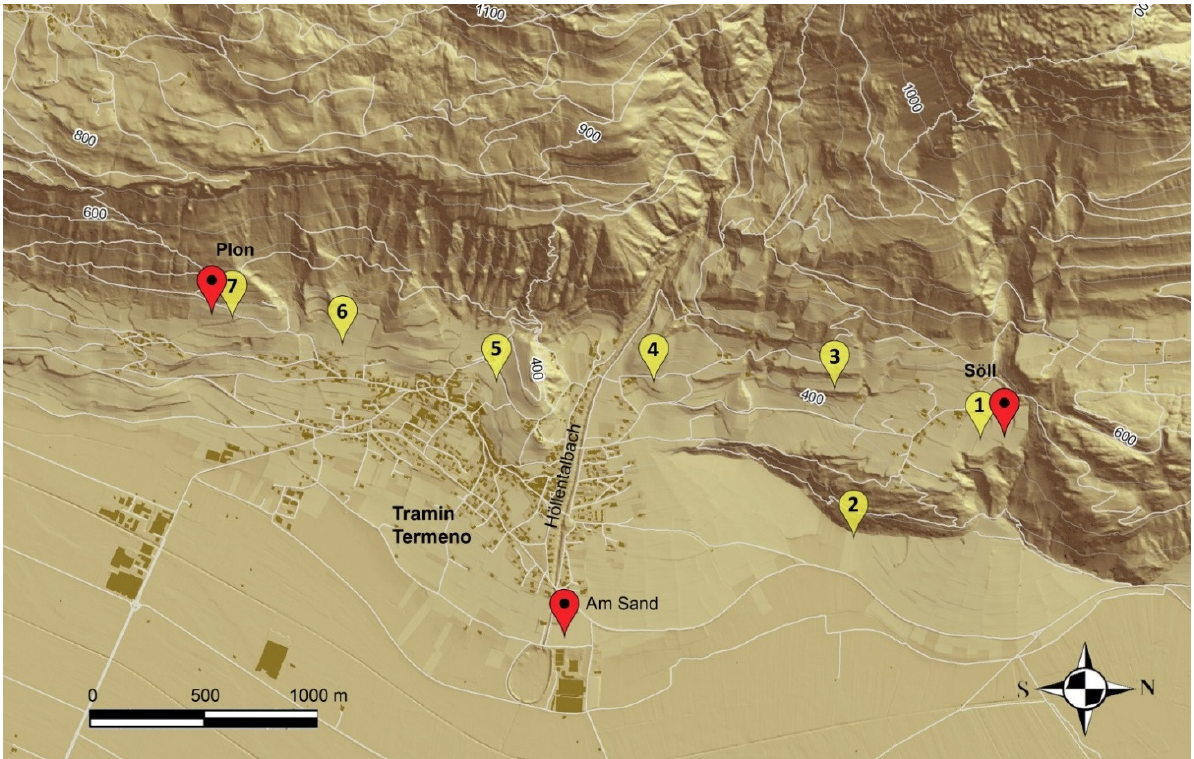
Figure 1. Location of the study area. The yellow markers show the seven vineyards, identified as vineyards V1–V7. The red markers indicate the three environmental multi-parameter measuring stations (cf. §6 and §7).